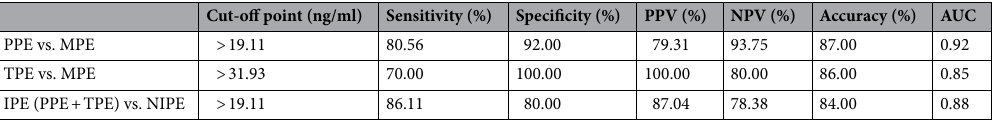
Table 3. Diagnostic performance of pleural fluid NAMPT based on the receiver operator characteristic (ROC) analysis. PPE parapneumonic effusion, MPE malignant pleural effusion, TPE tuberculous pleural effusion, IPE infectious pleural effusion, NIPE non-infectious pleural effusion, PPV positive predictive value, NPV negative predictive value, AUC area under the curve.